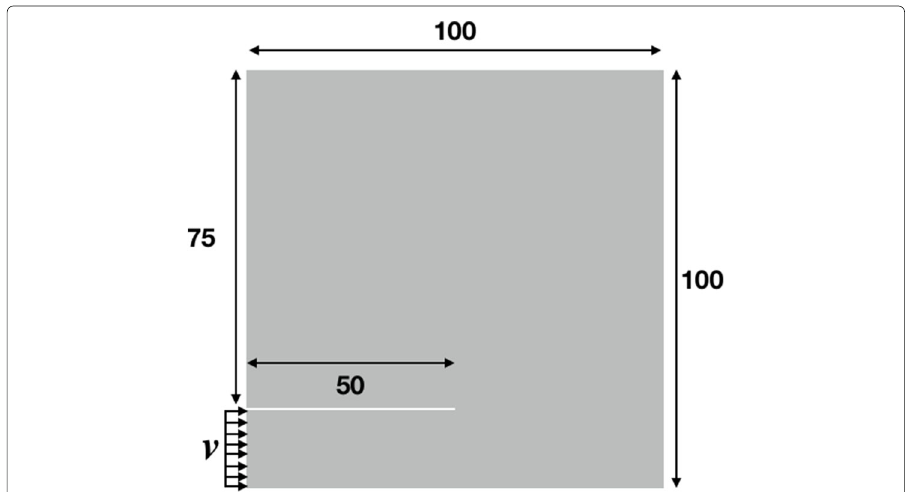
Fig. 16 Geometry, with dimensions in mm, and boundary conditions used in the dynamic shear tests. The y -displacements are fixed on the bottom surface